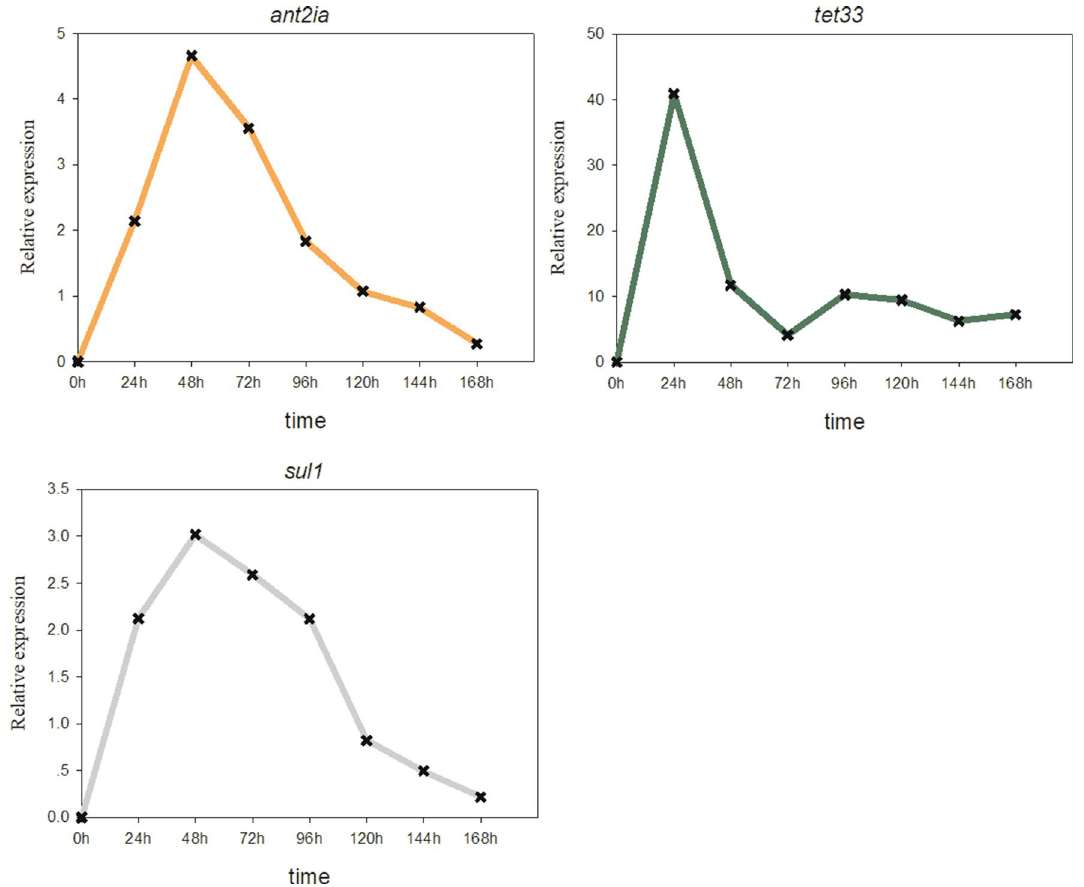
Figure 4. The expression levels of resistance genes tet33 , sul1 , and ant2ia changed at 24–168 h.